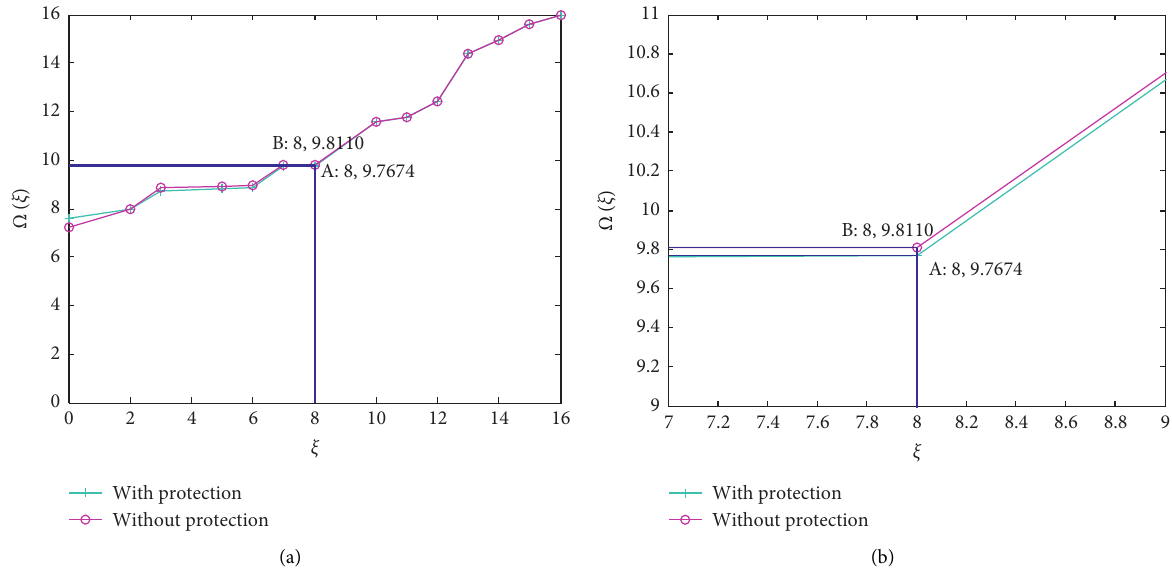
Figure 5: Conditional expected performance of system with and without protection. (a) The whole landscape. (b) The local landscape.